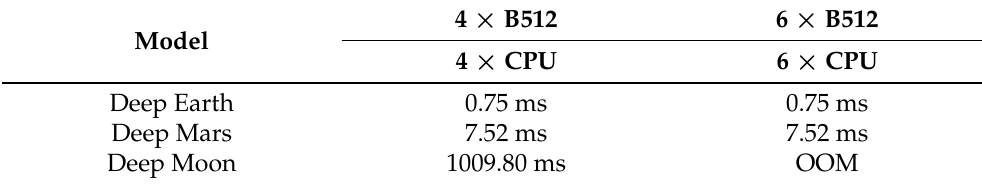
Table 12. Single-Stream benchmark results (90-percentile latency bound) for B512 DPU architecture.